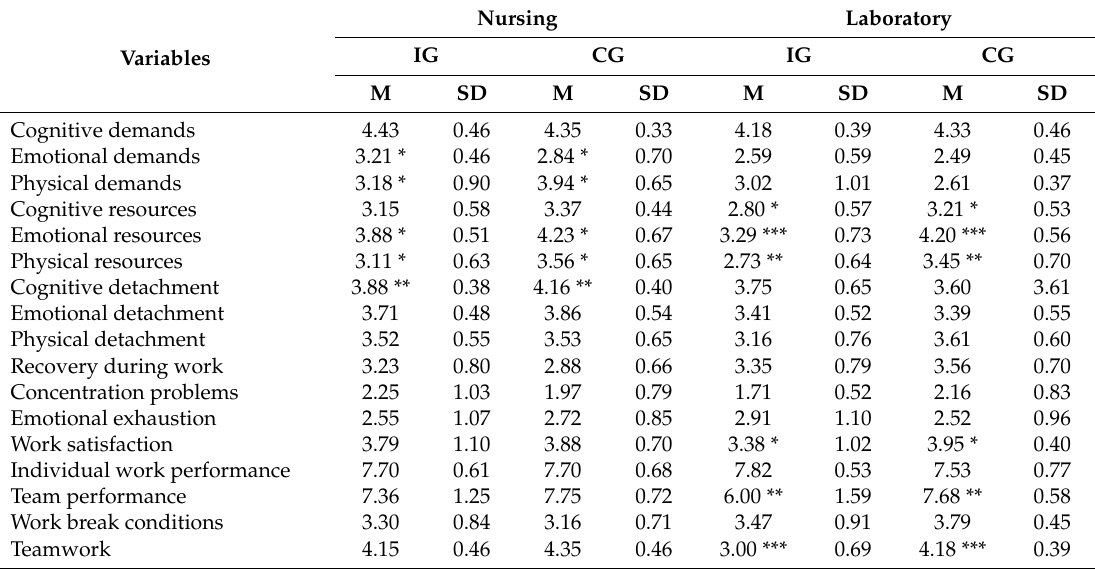
Table A2. Baseline means and standard deviations of study variables for all participating